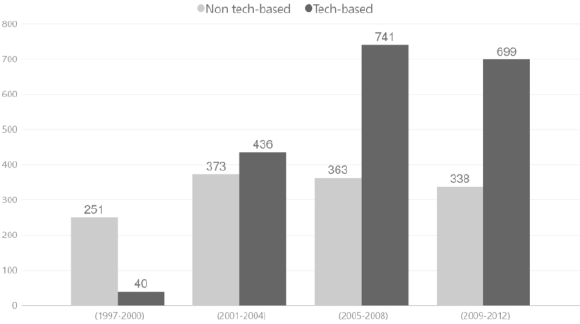
Figure 3 - Trends in using non tech-based and tech-